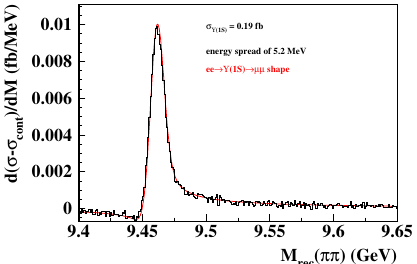
Figure 3. Υ (1 S ) signal in the recoil mass of the pion pair in the two-photons process e + e − → π + π − µ + µ − at the c.m. energy of 10.52 GeV. Normalized shape of the single photon e + e − → Υ (1 S ) signal as a function of e + e − energy is show in